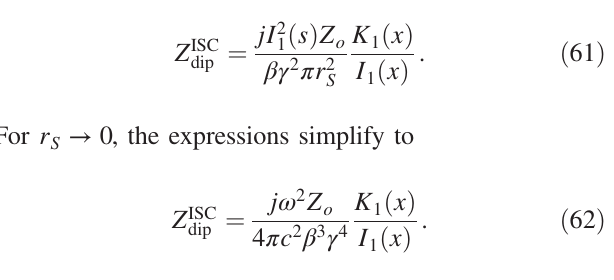
FIG. 10. Relative trapped mode frequency shift in the dipolar impedance with respect to TE 11 cutoff frequency for different relative thicknesses t=b . Comparison among mode matching, CST simulations and theory of [24]. Mode matching parameters: